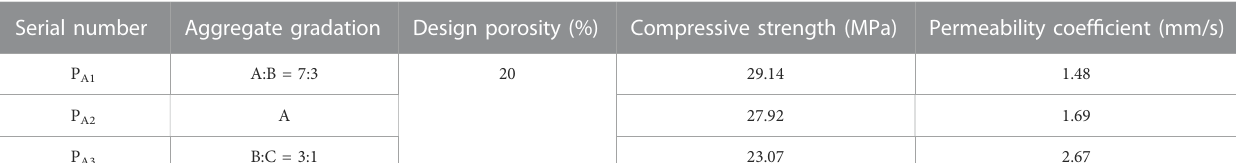
TABLE 5 Optimal performance result of permeable concrete.